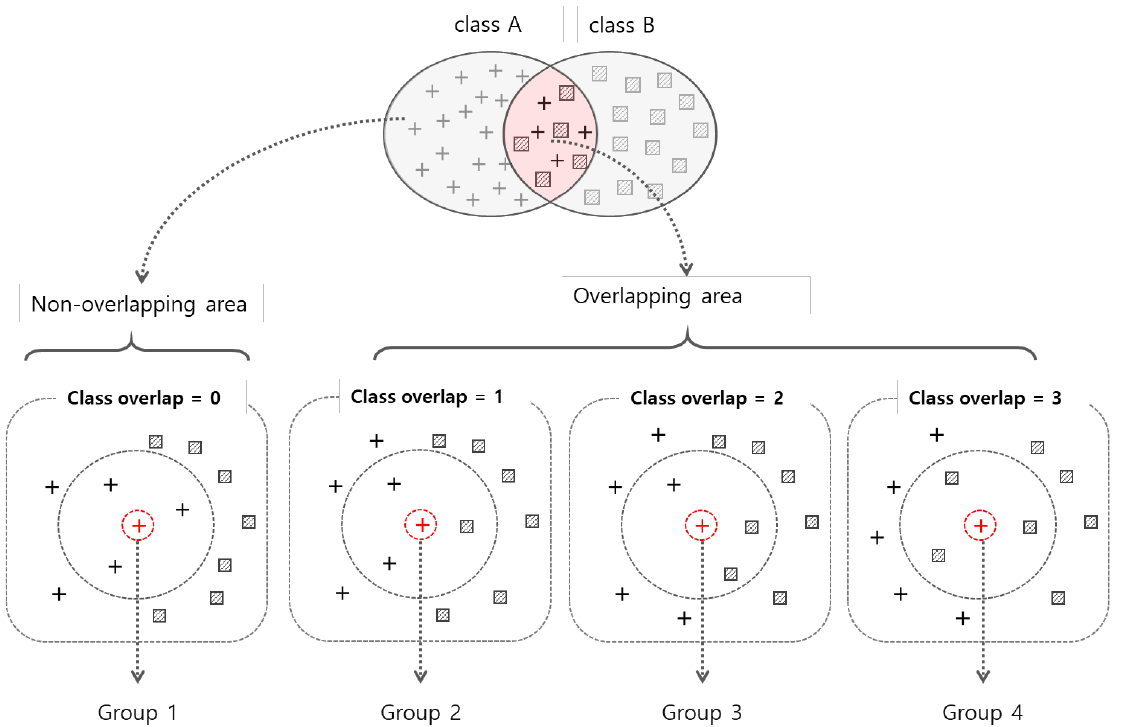
Figure 3. An example of grouping of data instances according to the class overlap number where k =